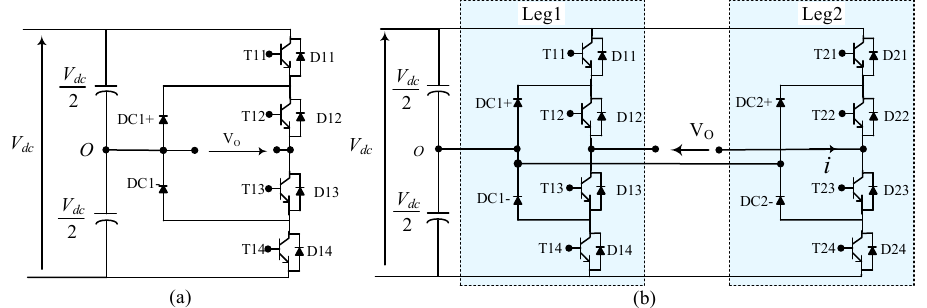
Figure 2. ( a ) Three-level NPC topology (for one phase); ( b ) HB-5L-NPC topology (for one phase).